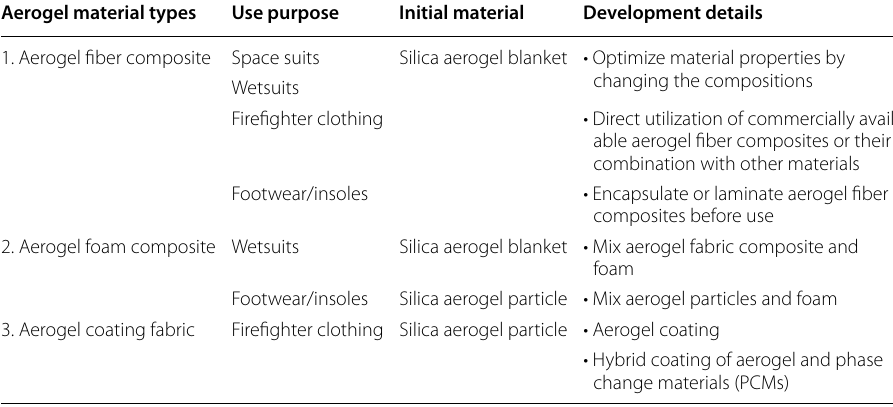
Table 2 Development details of the three types of aerogel materials Aerogel material